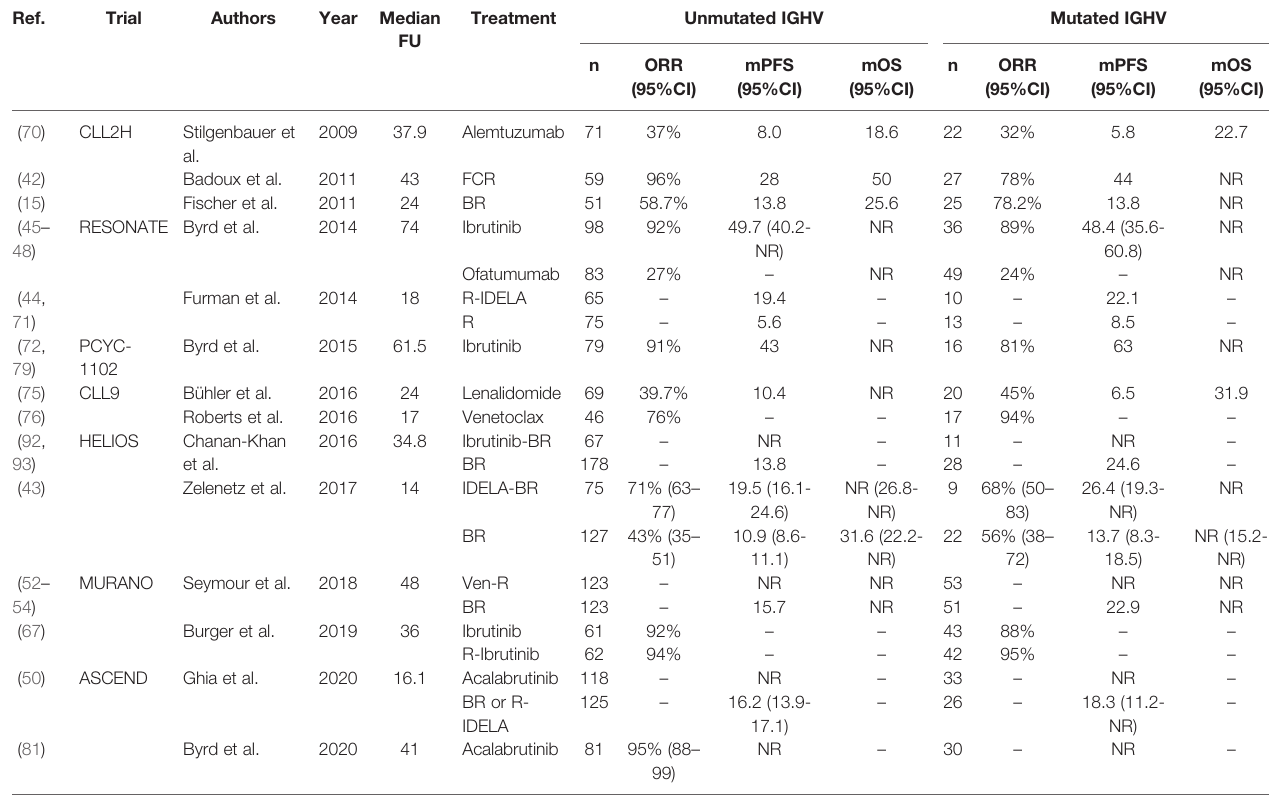
TABLE 7 | An overview of clinical trials comparing treatment regimens for patients with relapsed or refractory U-CLL.